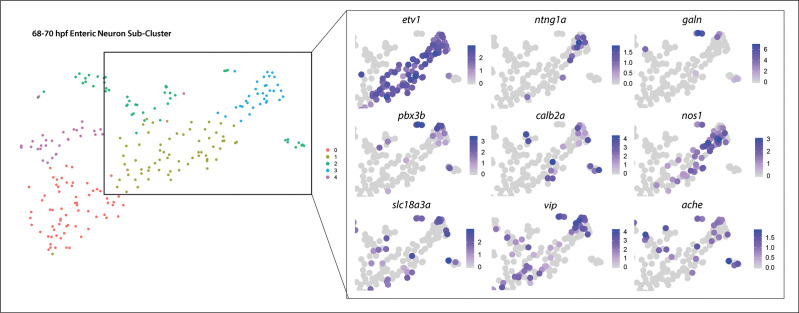
Enteric neuron subtype diversification gene expression patterns seen in enteric neuron Sub-clusters related to Figure 5D,E Panel of tSNE feature plots magnified and cropped to focus on progressively differentiating enteric neurons (highlighted by etv1 expression).Subtype diversification and IPAN emergence depicted via combinatorial gene expression (etv1, ntng1a, pbx3b, slc18a3a, calb2a, and ache) localized to the distal tip of Sub-cluster 3. Inhibitory neuron markers, nos1, vip, and galanin (galn) were present within the pocket of diverging enteric subtypes.